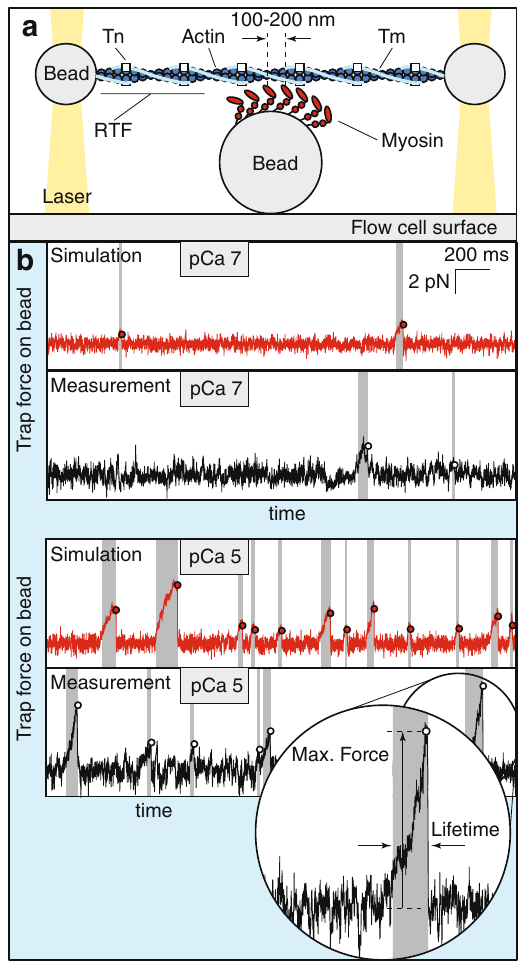
Figure 2. Ca ++ affects the maximum force, duration and frequency of binding events from a mini-ensemble of myosin interacting with a regulated thin filament (RTF). ( a ) Cartoon of the mini-ensemble laser trap (not to scale). ( b ) Measured (black) and simulated (red) data, showing the force applied by the laser trap on one of the beads as a function of time. Binding events (shaded) are less frequent, shorter, and reach a smaller maximum force (hollow dot) at low Ca ++ (pCa 7) than at high Ca ++ (pCa 5). Inset shows how our custom event detection algorithm identifies maximum event force and lifetime. For these traces, trap stiffness was 0.0298 pN/nm (pCa 7) and 0.0382 pN/nm (pCa 5). ATP concentration is 100 μ